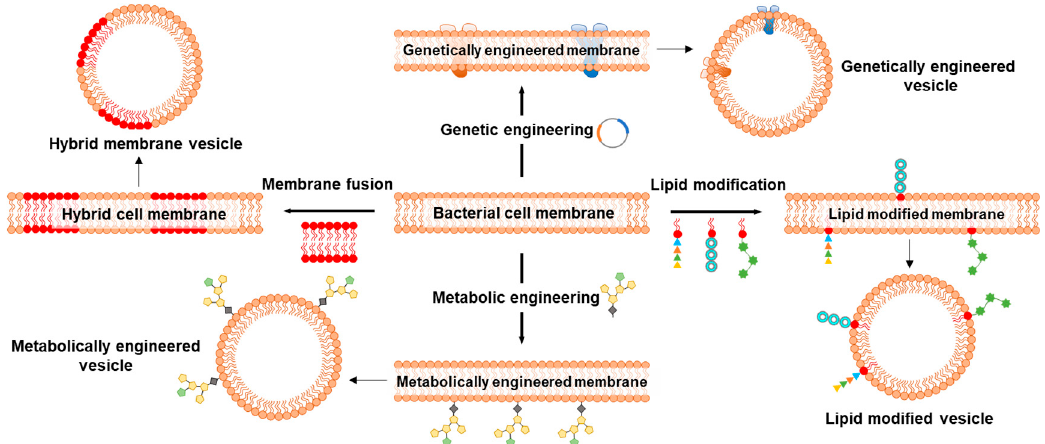
Figure 12. Schematics representing important strategies to modify bacterial cell membranes for application in biosensing, disease prevention, and treatment. Membrane fusion approach to producing hybrid membranes to combine the properties of two different cell types. Genetic engineering for the expression of transmembrane channels, receptors, porins, and efflux pumps that are otherwise difficult to incorporate using traditional techniques. Lipid modification strategy to enhance the affinity of cell membrane lipids to anchor ligands onto the NPs. Metabolic engineering to modify cell surface glycans that can be studied for their participation in conjugation and immunogenic responses.